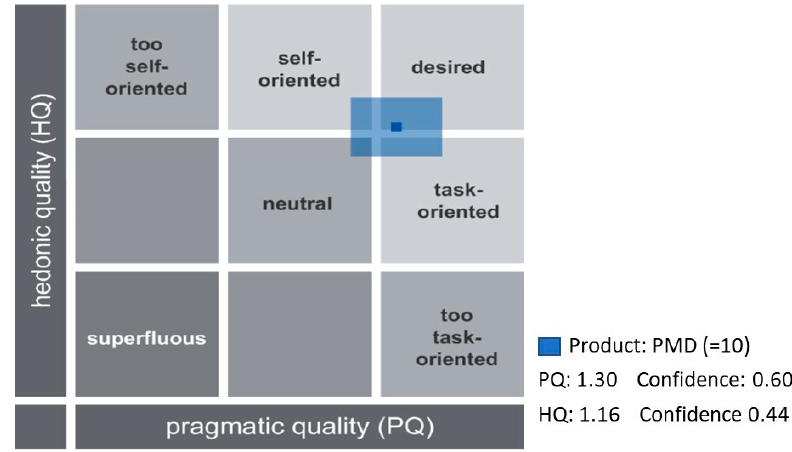
Figure 4. Overall evaluation of hedonic and pragmatic qualities for the study 3.2.2.